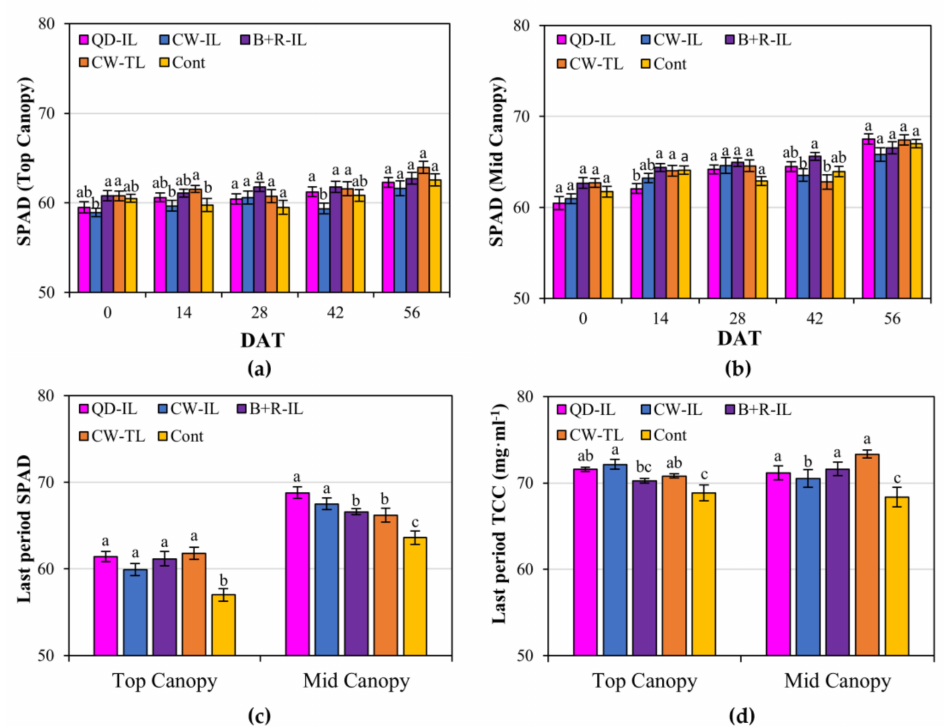
Figure 2. Leaf characteristics, especially chlorophyll content, of paprika plants for each canopy during supplemental lighting application. ( a , b ) Variations in SPAD values. ( c , d ) SPAD and total chlorophyll content (TCC) of leaves harvested in the last period of cultivation. Supplemental lighting treatments: QD-IL, QD inter-lighting; CW-IL, cool-white inter-lighting; B+R-IL, blue + red inter-lighting; CW-TL, cool-white top-lighting; Cont, without supplemental lighting. Vertical bars indicate ± SEM (n = 21) in ( a – c ) and ± SEM (n = 9) in ( d ). Values marked with different letters indicate significant differences according to Duncan’s multiple range test at the 5%